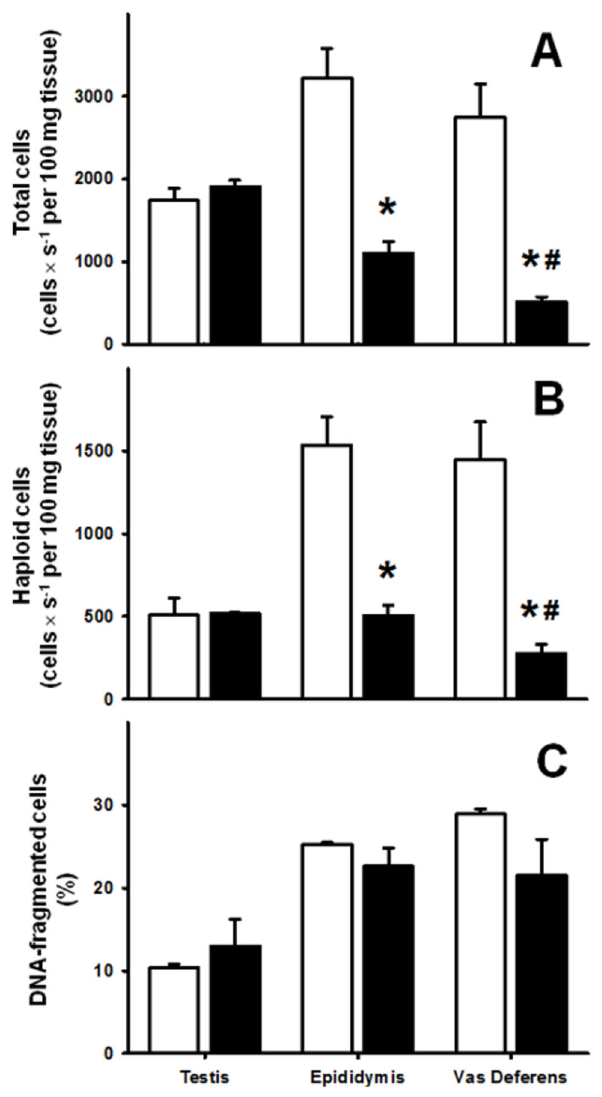
Figure 3. Representative photomicrographs (Masson’s Trichrome) of vas deferens tissue. The epididymal (A–D) and prostatic (E–H) portions of vas deferens from CTRL and CM rats are indicated in the legends on the left side of the panels. Key: In the middle low magnification panels: l, lumen; em, epithelial mucosa; mc, muscular coat. In the right high magnification panels: l, lumen; e, epithelium; lp, lamina propria. The panels are representative figures of four histological analyses in different fields using six different male rats in each